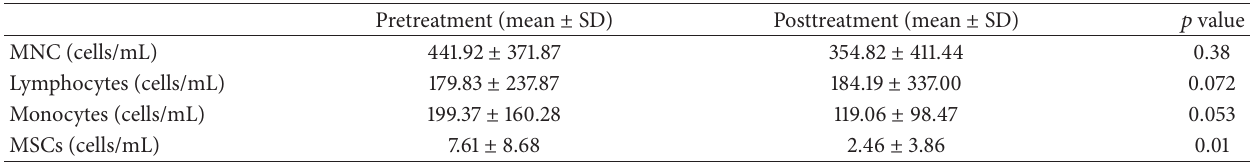
Table 3: Phenotypic characterization of the cell populations in SF of IO